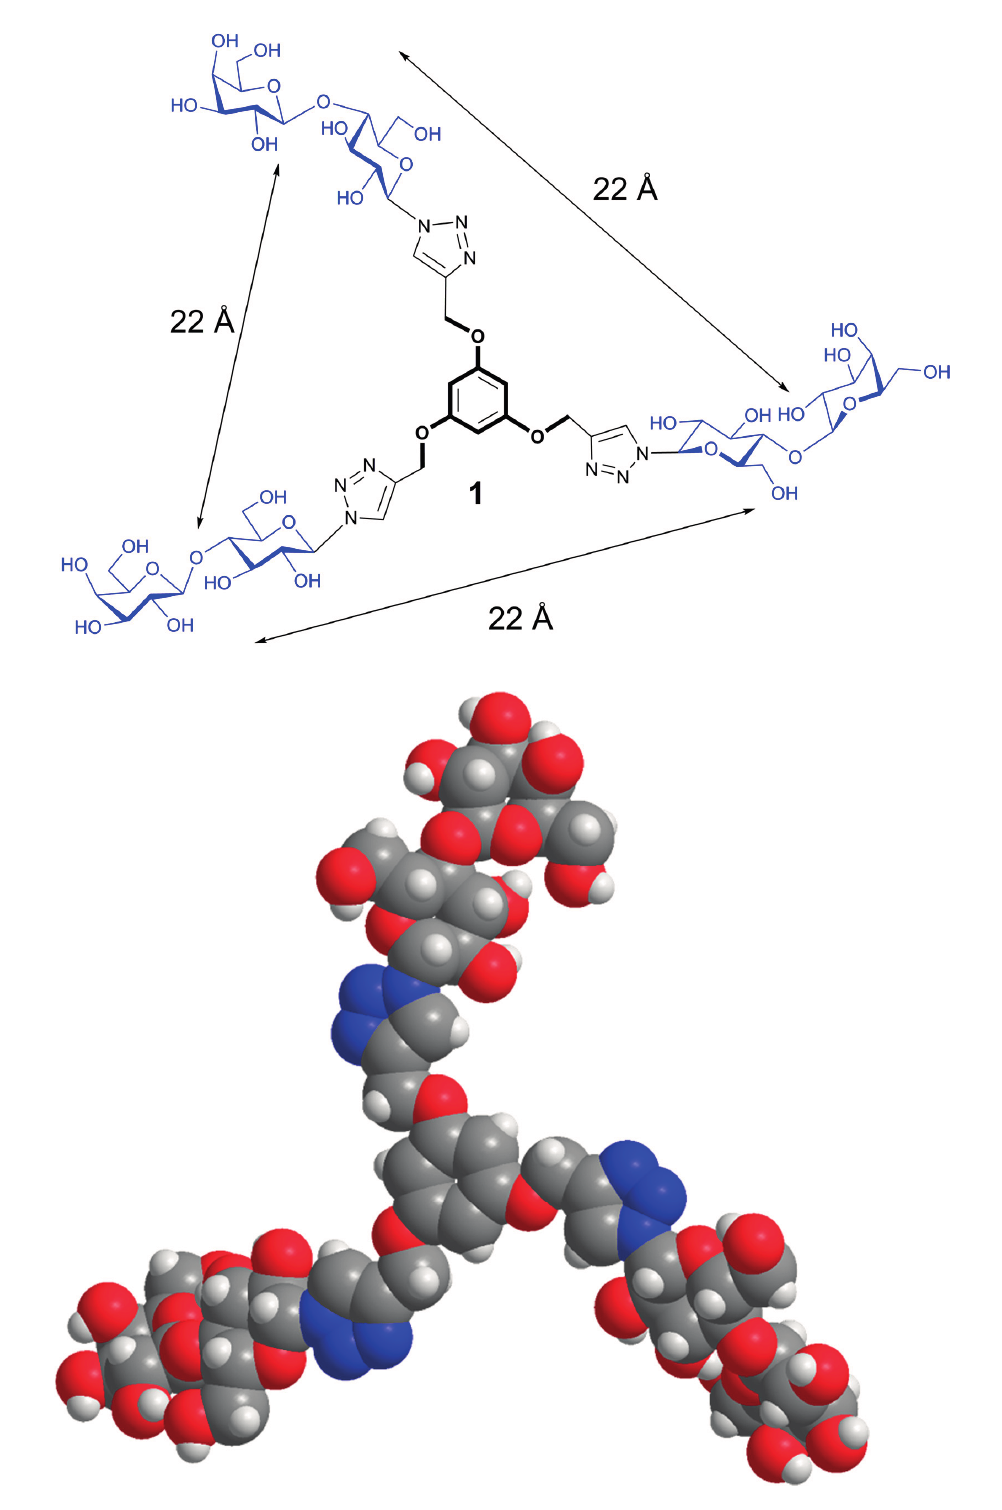
Figure 12. Computer-based estimation of the distances between branch ends of the 1,3,5-trimethoxybenzene-based trivalent glycocluster 1 (for synthetic route, please see Scheme 1) and presentation of the conformer with C-3 symmetry. Dynamic fluctuations in space and time enable the glycocluster to access conformers with distances between 20–25 Å, then losing the C-3